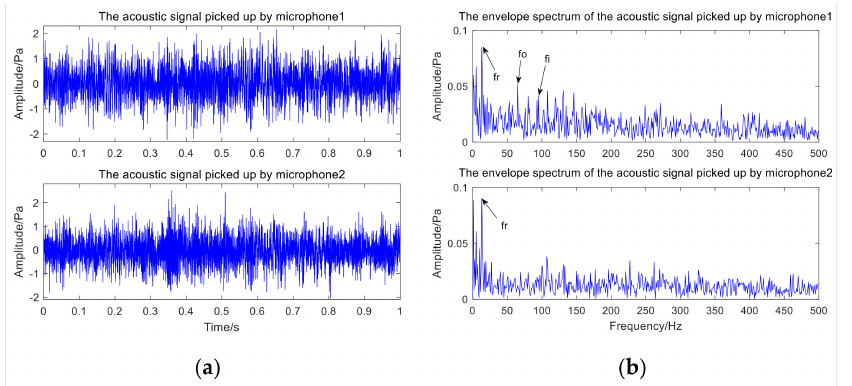
Figure 13. Time and spectral domain results of compound fault acoustic signals: ( a ) time-domain waveform of acoustic signals; ( b ) envelope spectrum of acoustic